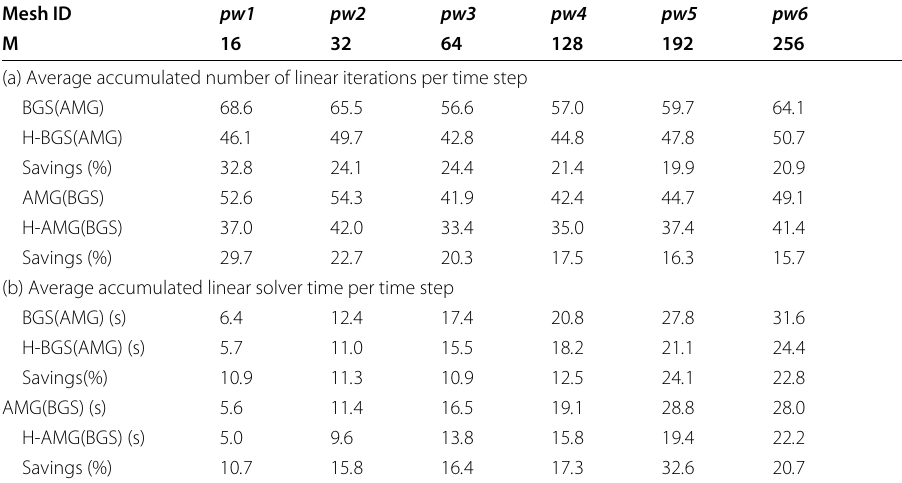
Iterationcountsofthelinearsolverarenotsensitivew.r.t. meshrefinementforalltypesofpreconditioners. Timingsofthelinearsolverexhibitonlyslightincreaseswithmeshrefinementduetotheimplementation.Relativesavings duetothehybridpreconditionerarereported